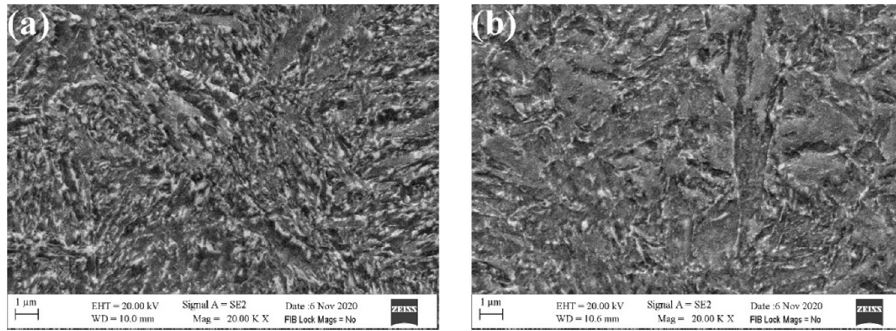
Figure 4: The initial microstructure of the two steels by SEM: ( a ) 5CrNiMoV and ( b ) 5CrNiMoVNb.